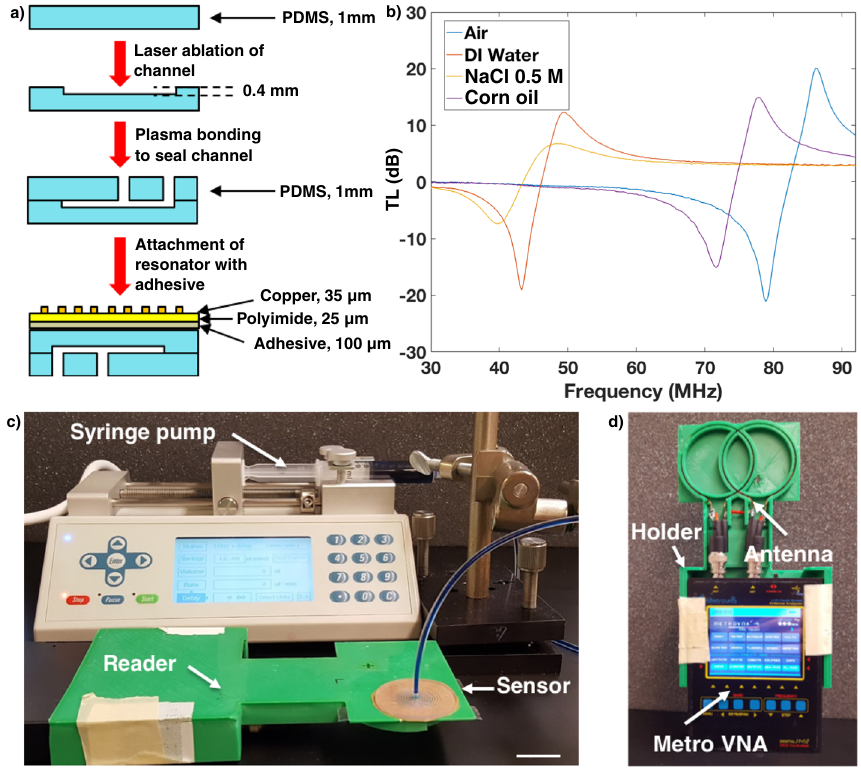
Fig. 2 Sensor fabrication and interrogation. a Flow diagram for sensor fabrication with side view showing layer build up. b Bode plot showing the effect of different dielectric media on the resonator ’ s transmission loss. Resonator was attached to bottom of petri-dish with 10 mL of liquid for all trials. c Experimental setup for characterization of sensor using a syringe pump to fi ll channels with a custom reader, scale bar = 2 cm. d Custom reader setup including 3D printed holder, double loop interrogation antenna, and portable VNA